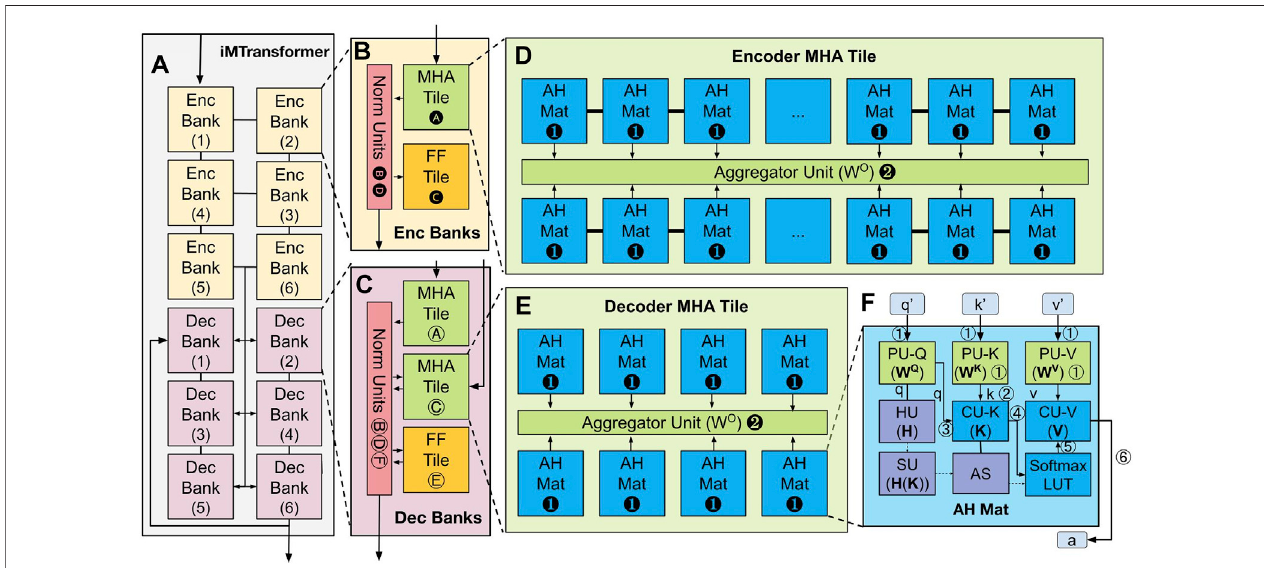
FIGURE 3 | The iMTransformer follows a hierarchical memory structure. The iMTransformer (A) is composed of encoder (B) and decoder (C) banks. The encoder bank is composed of an encoder MHA tile (D) and FF tiles and normalization units. The decoder bank is composed of two decoder MHA tiles (E) , an FF tile and a normalization unit. The encoder (D) and decoder (E) MHA tiles are composed of AH Mats (F) and an aggregator unit.